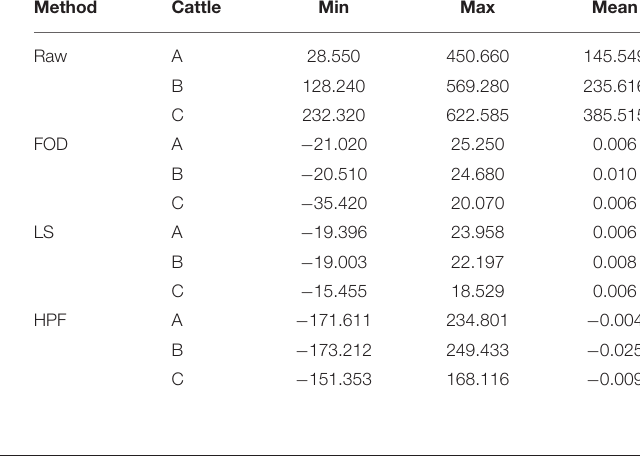
TABLE 4 | Numerical statistical comparison of ruminant waveform data preprocessing.